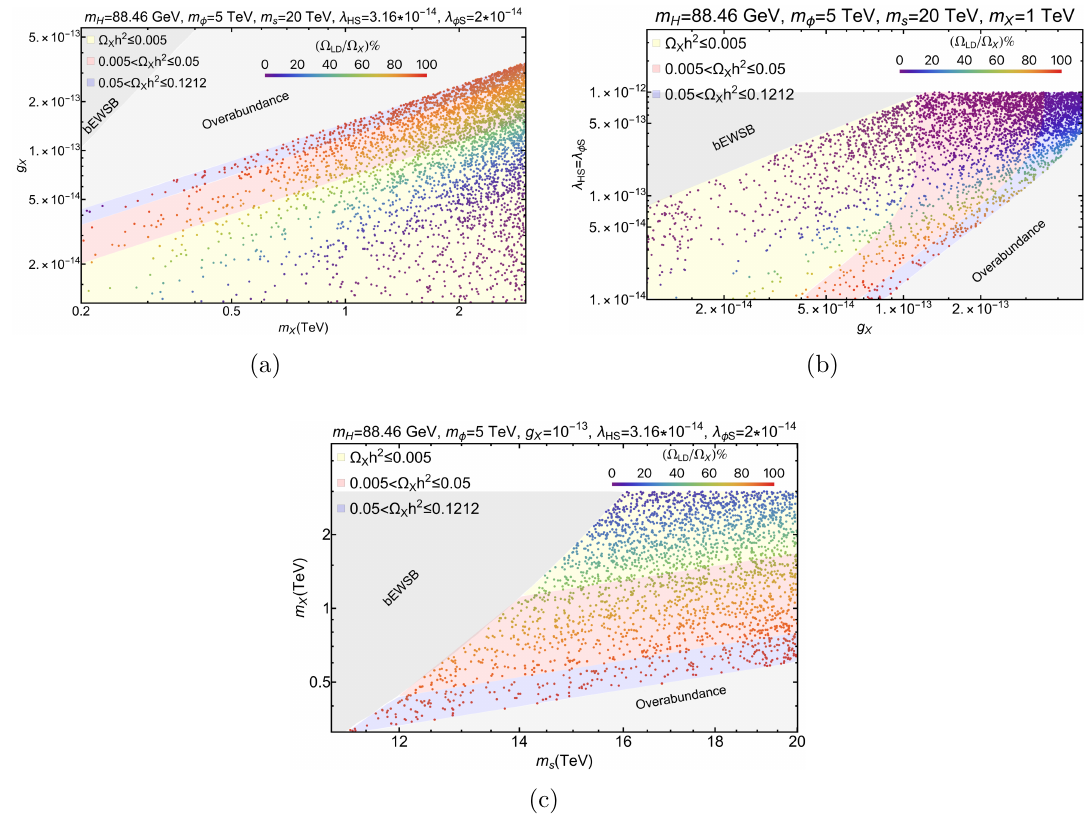
Figure 8 . Numerical scan of the under-abundant region of X relic (eq. (4.23)) for freeze in bEWSB, when (2 m X ≤ m s ) . Figures 8(a) shows scan in m X − g X plane, 8(b) in g X − λ HS = λ φS plane and 8(c) in m s − m X plane. Different colour shades indicate different ranges of relic density for fixed values of other parameters within our said bound as mentioned in figure inset and caption. The rainbow colour bar represents the contribution of the late decay of s in X freeze-in by the ratio (Ω LD / Ω X ) . This kinematic region is free from collider and direct search constraints, see text for